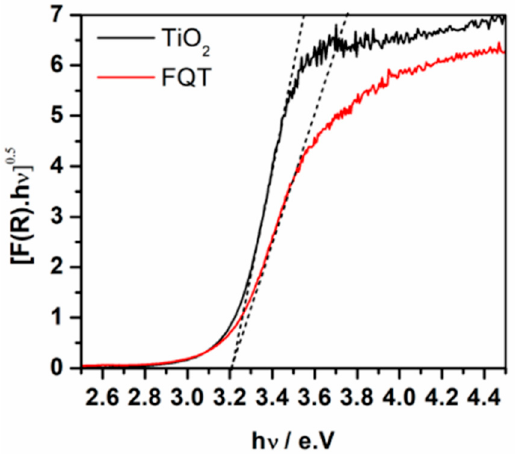
Figure 4. UV-vis absorption spectra presented as the modified Kubelka–Munk function of free TiO 2 and TiO 2 –SiO 2 –Quartz composite (FQT).